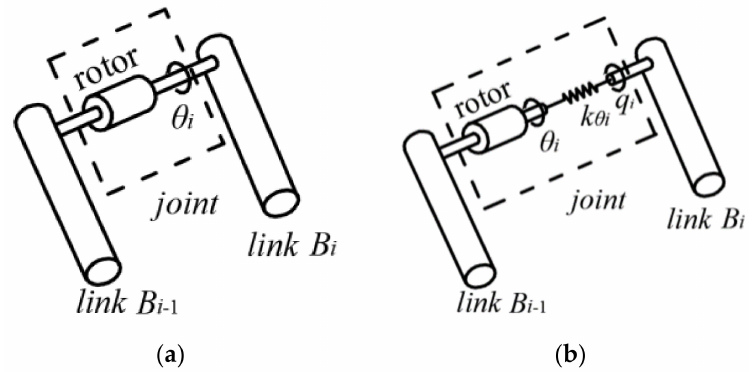
Figure 1. The simple model of joint. ( a ) The rigid-joint; ( b ) The flexible-joint. The free-floating multi-flexible space manipulator system is composed of a rigid-base B 0 , n links B 1 ~ B n , and n flexible-joints O 1 ~ O n , as shown in Figure 2. ( OXY ) is the inertial frame, ( O 0 x 0 y 0 ) is the base frame, ( O i x i y i ) is the coordinate frame attached to the link B i ( i = 1, 2, · · · , n ). The base’s center of mass is O 0 , its position vector is r 0 ; r i is the position vector of B i ‘s center of mass. C is the system’s center of mass, its position vector is r c . Meanwhile, q 0 is the attitude angle of the base, which is the angle between the x 0 axis and the X axis; q i is the angle between the x i − 1 axis and the x i axis, θ i is the rotation angle of the motor rotor in the joint O i